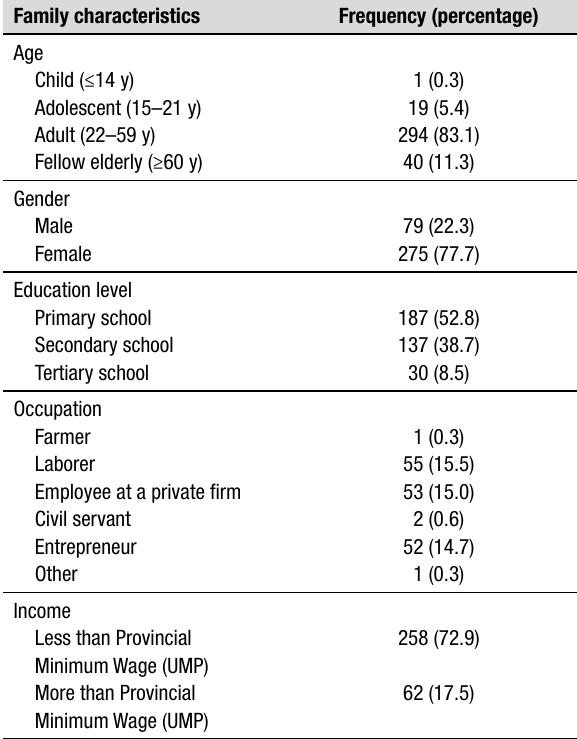
Table 1. Characteristics of families caring for the elderly. Family